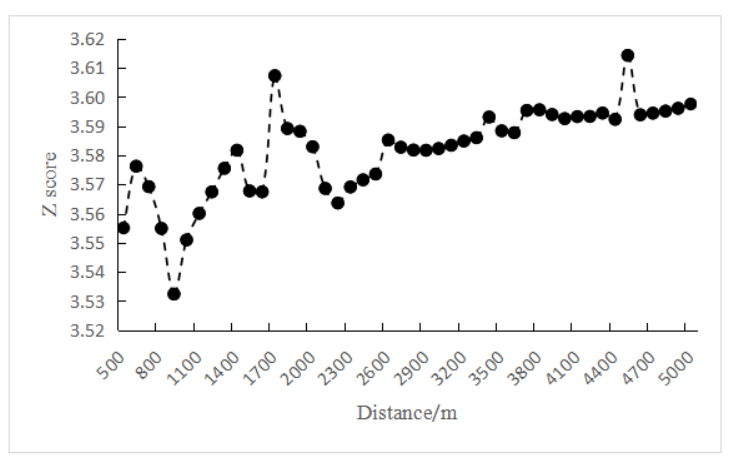
Figure 7. Global spatial autocorrelation Z scores of crime point distribution.